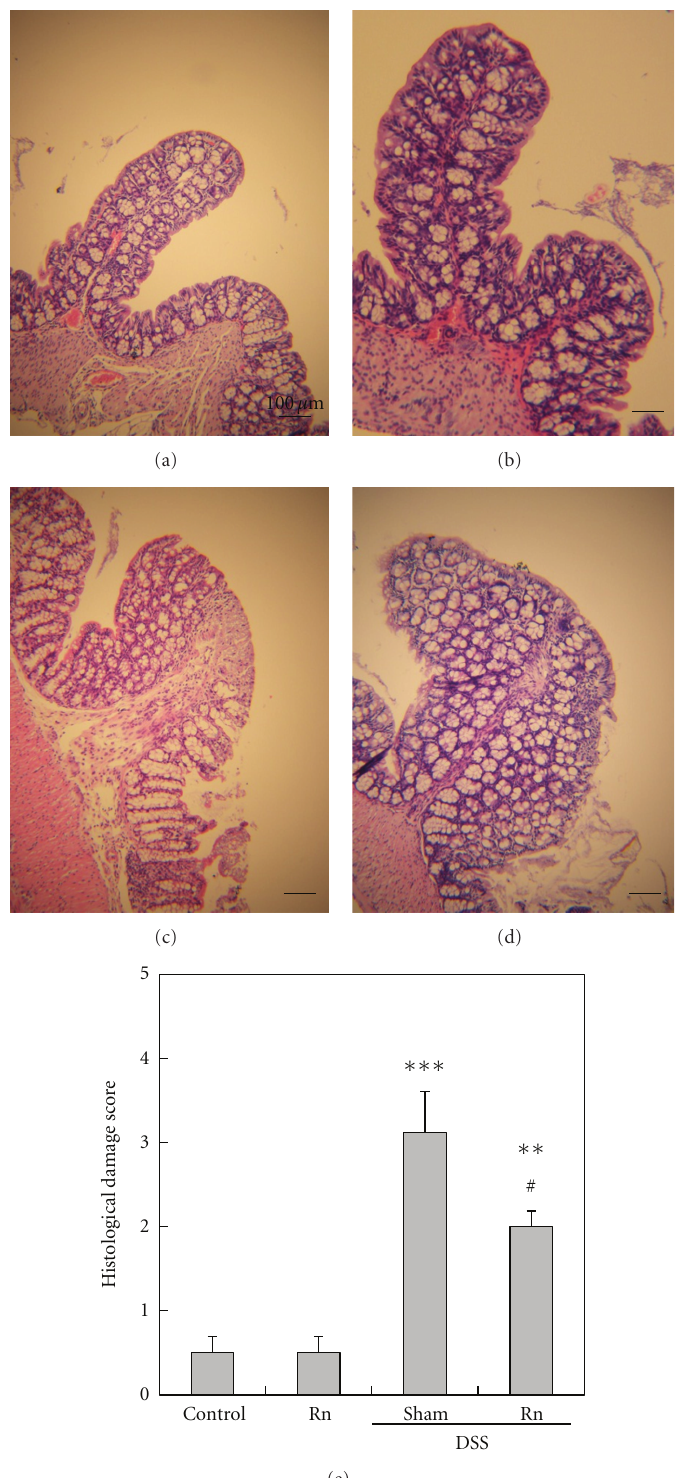
Figure 2: E ff ects of radon inhalation on mucosal damage after colitis induction. (a) Control, (b) radon inhalation only, (c) sham inhalation with DSS administration, and (d) radon inhalation with DSS administration. All samples were stained with hematoxylin and eosin (HE). Scale bar is 100 μ m ( × 100). (e) Lower histological damage score of mucosa in mice treated with radon inhalation than in mice treated with sham inhalation. Each value is the mean ± SEM. The number of mice for each experiment and significance are the same as in Figure